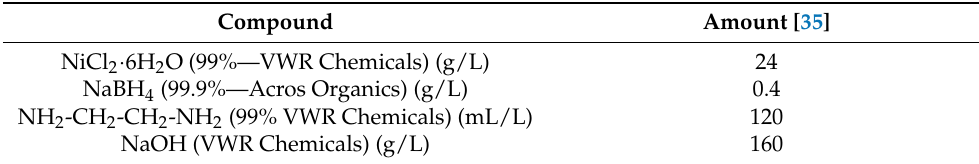
Table 1. Composition of electroless nickel-boron deposition bath.